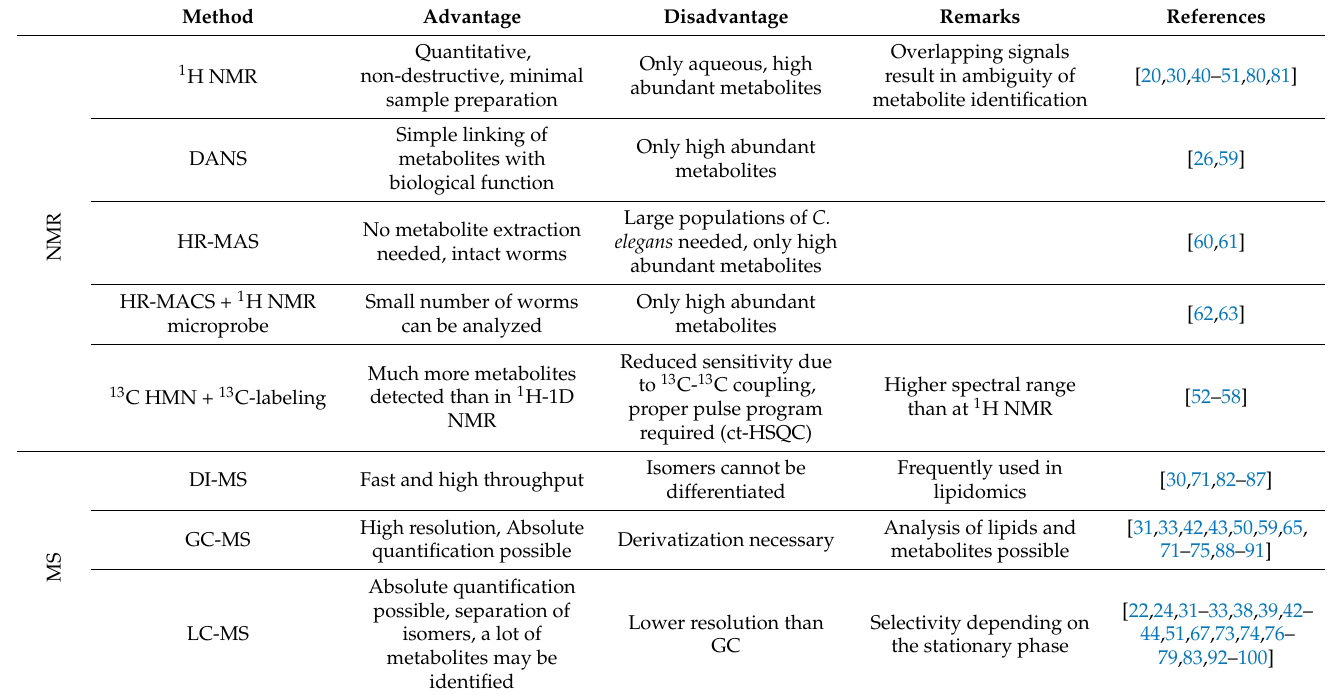
Table 1. Overview on analytical methods used in C. elegans metabolomics/lipidomics and their advantages, disadvantages and corresponding